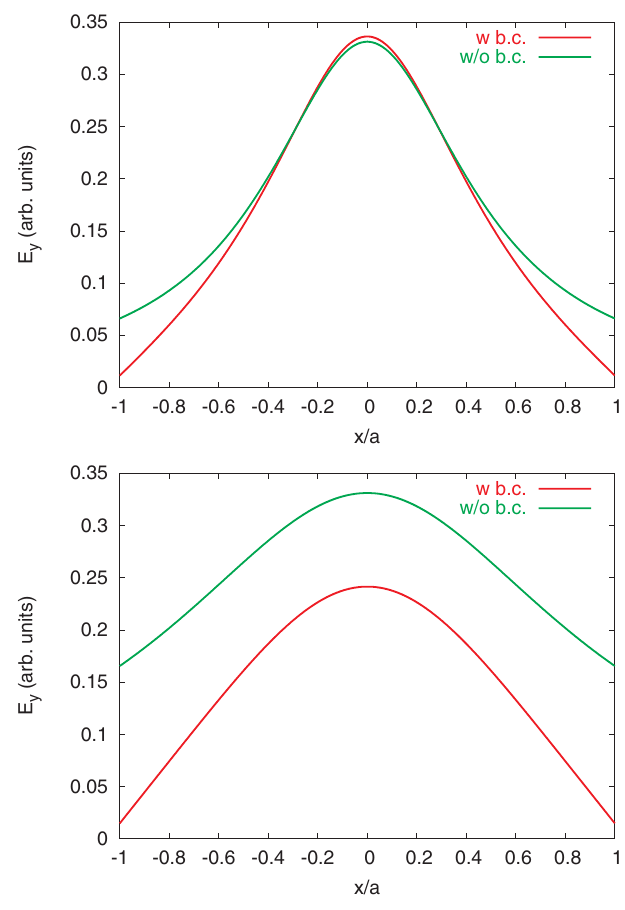
FIG. 2. (Color) Vertical electric field as a function of the hori- zontal position along the axis y (cid:2) (cid:5) b= 2 of a square (top) and of a rectangular chamber with a (cid:2) 2 b (bottom), computed with and without conducting boundary conditions, for a beam centered in (cid:2) a= 10 the chamber, with a transverse rms size (cid:1) b